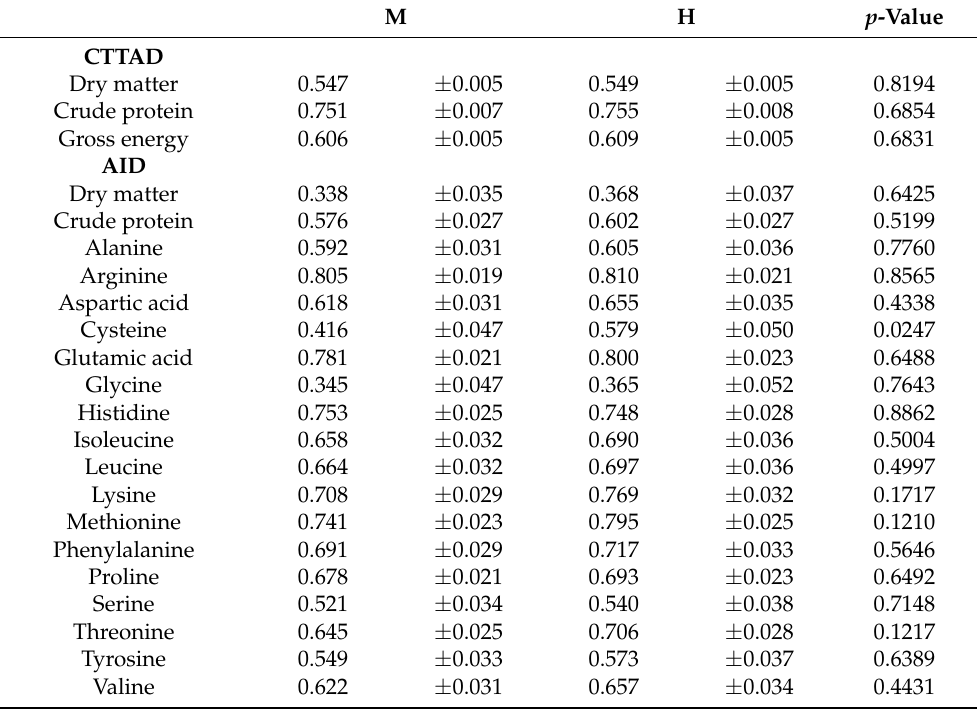
Table 3. Coefficient of total tract apparent digestibility (CTTAD) of the main nutrients (n = 24) and apparent ileal digestibility (AID) of dry matter, crude protein and amino acids (n = 32) from animals fed the experimental diets (M and H) during the fattening period (average ± standard deviation). M H p -Value CTTAD